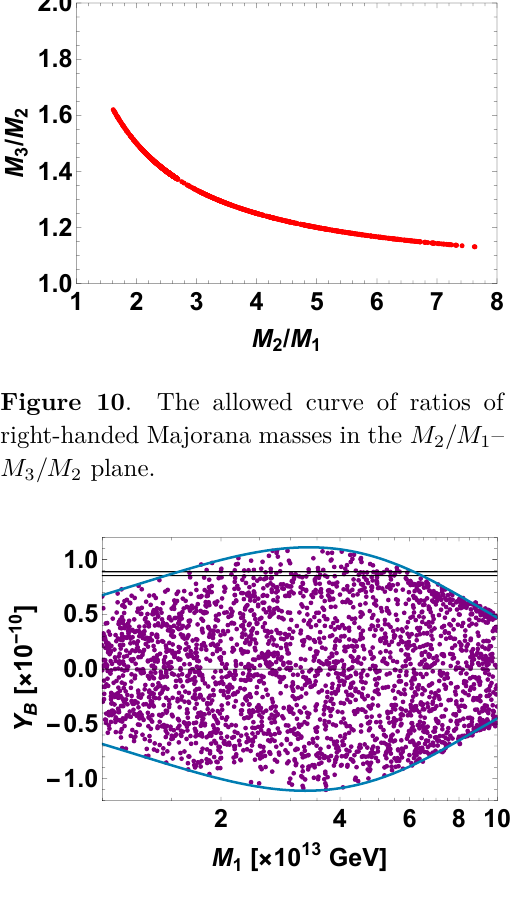
Figure 12 . Predictive Y B versus M 1 . Points correspond to the output of section 4 at 3 . Horizontal lines denote the upper and lower bounds of observed Y B in eq. (5.1). The blue solid curves denote the boundary of Y B